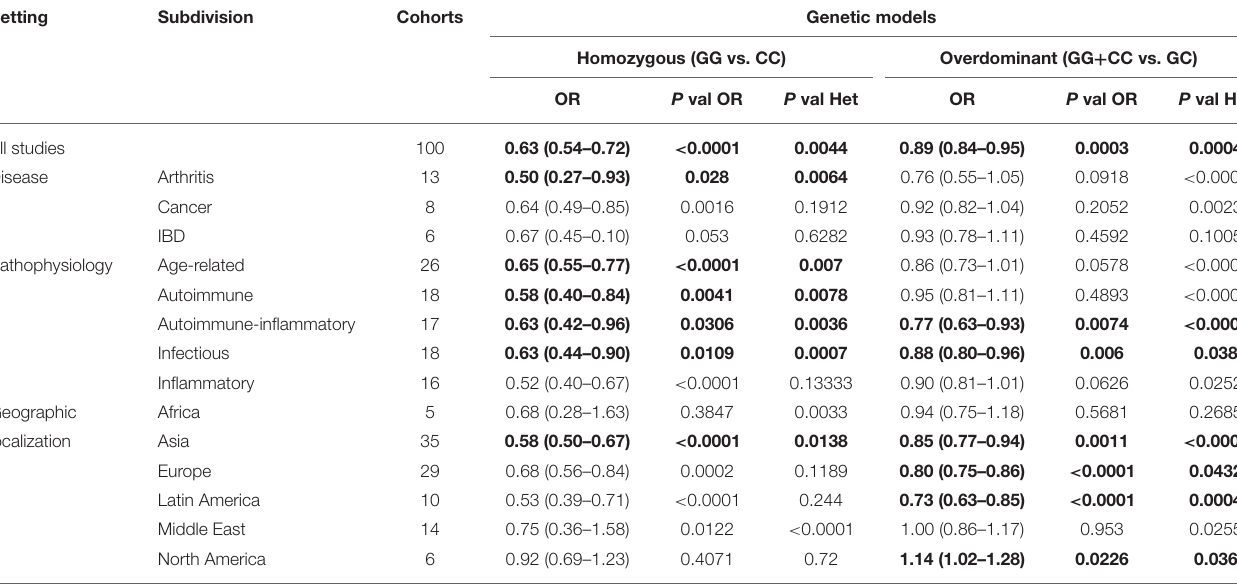
TABLE 3 | Summary of the overall and all subdivisions meta-analysis results on homozygous and overdominant models.